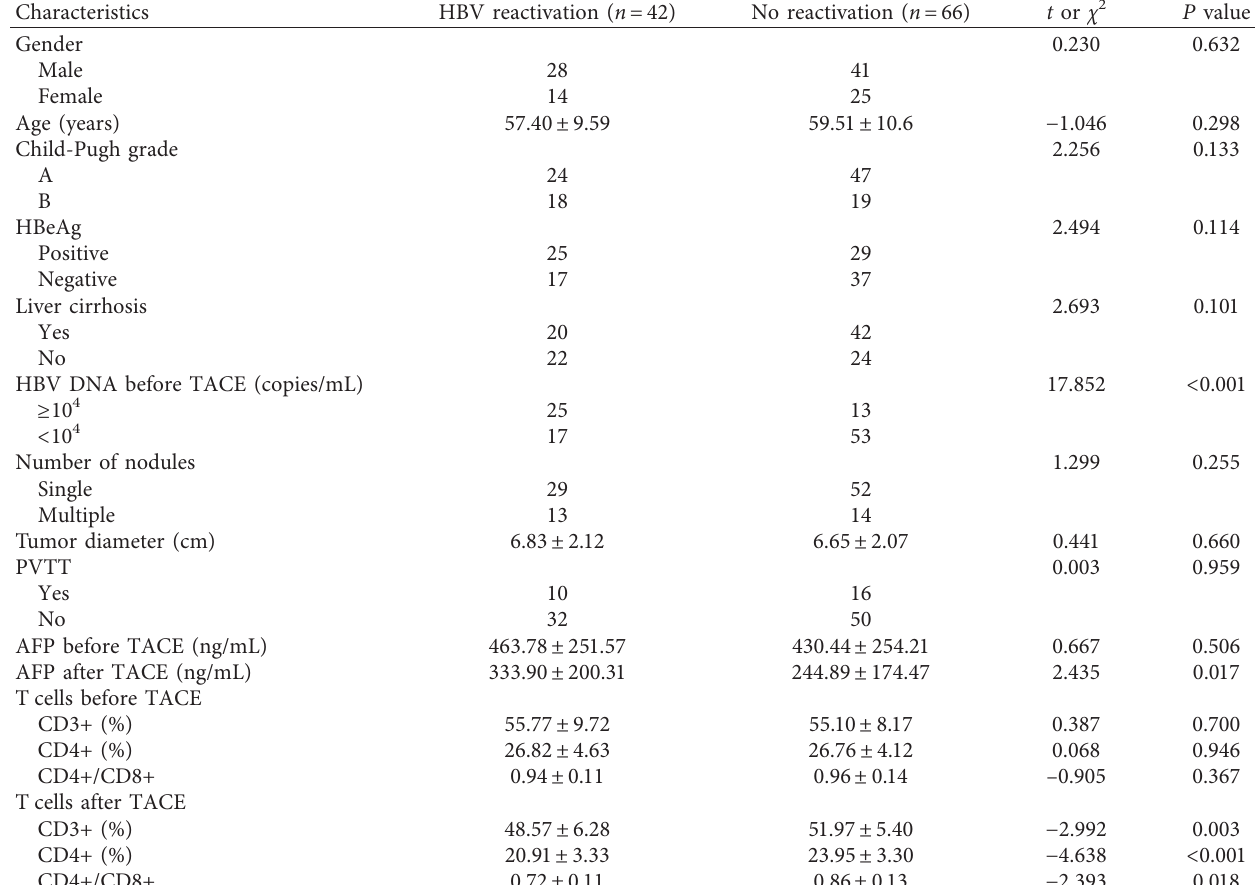
Table 2: Characteristics and changes in patients with HBV reactivation and those without HBV reactivation.